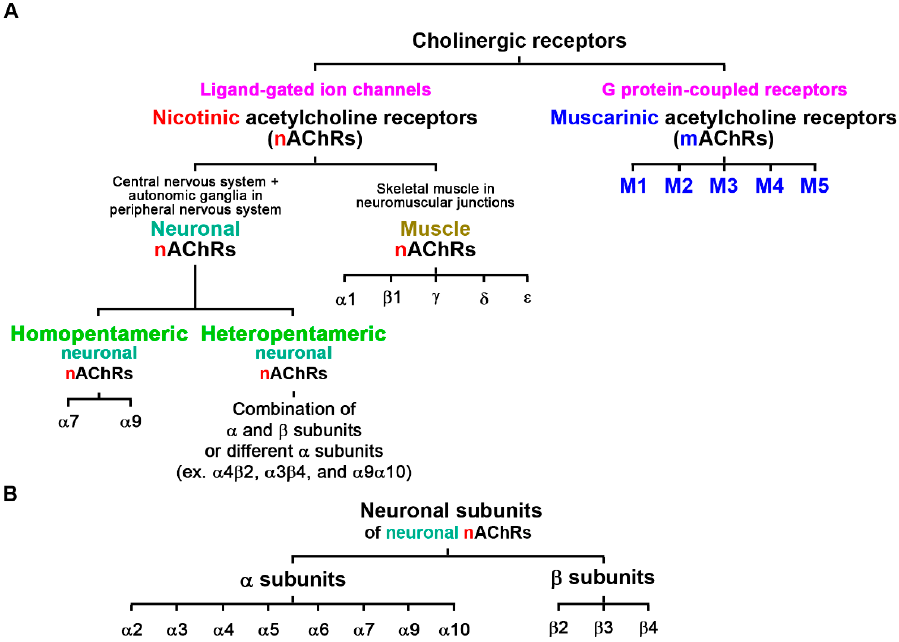
Figure 1. Classification of cholinergic receptors and subunits of neuronal nicotinic acetylcholine re- ceptors (nAChRs). ( A ) Cholinergic receptors contain nicotinic and muscarinic acetylcholine receptors. ( B ) Neuronal subunits of neuronal nAChRs in mammalians ( α 8 is cloned from the chicken brain).